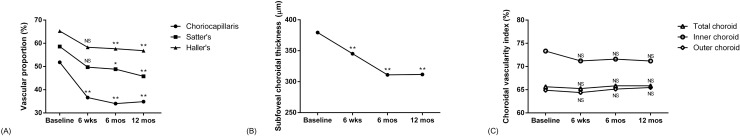
Changes in choroidal vascular proportions of en face images, subfoveal choroidal thickness, and choroidal vascularity index of B-scan images in CSC eyes after half-fluence photodynamic therapy (HF-PDT).(A) The vascular proportion in the choriocapillaris significantly decreased after HF-PDT (6 weeks: P < 0.001; 6 months: P < 0.001; 12 months: P < 0.001). The vascular proportions in Sattler’s and Haller’s layers did not show a significant decrease at 6 weeks (Sattler’s: P = 0.052 and Haller’s: P = 0.558) but decreased significantly at 6 months (Sattler’s: P < 0.001 and Haller’s: P = 0.027) and 12 months after HF-PDT (Sattler’s: P < 0.001 and Haller’s: P < 0.001). (B) The SCT decreased significantly after HF-PDT (6 weeks: P = 0.007; 6 months: P < 0.001; 12 months: P < 0.001). (C) The CVIs of the total choroid (6 weeks: P = 0.448; 6 months: P = 0.710; 12 months: P = 0.718), the inner choroid (6 weeks: P = 0.370; 6 months: P = 0.410; 12 months: P = 0.189), and the outer choroid (6 weeks: P = 0.434; 6 months: P = 0.653; 12 months: P = 0.354) showed no significant changes after HF-PDT. NS: not significant, *P < 0.05, ** P < 0.01; paired Student's t-test.